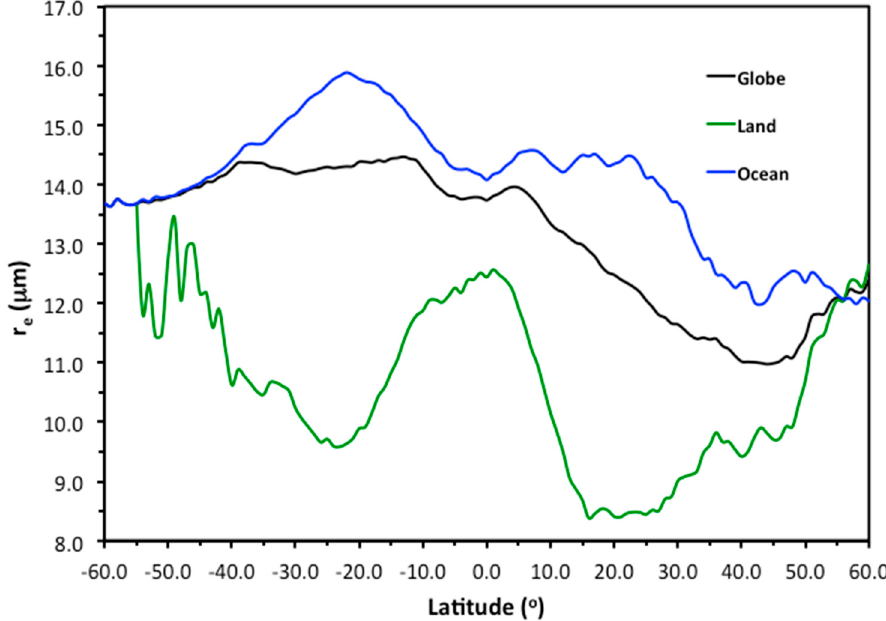
Figure 3. Zonal distribution of CDER for the long-term averaged monthly mean data.